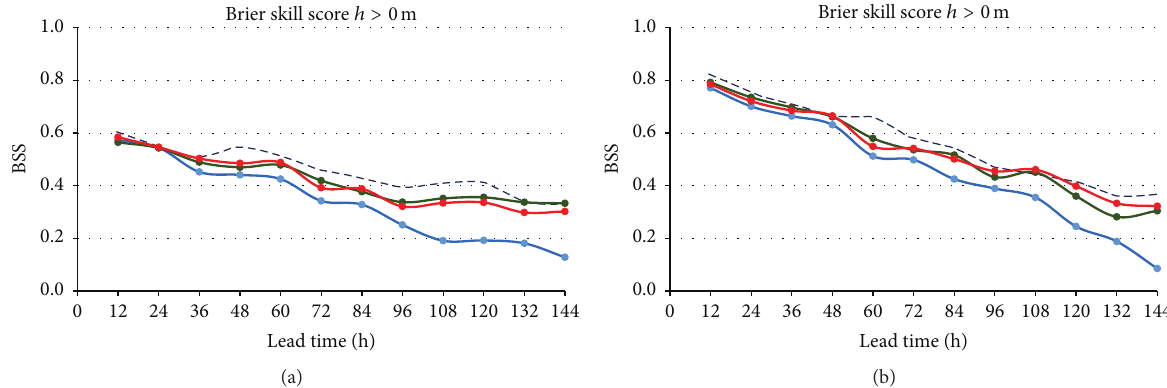
Figure 4: Brier skill score as function of lead time for the MULTIPDF dressing method applied to three different forecasts (green continuous cum dotted line: DF, red continuous cum dotted line: EMF, and blue continuous cum dotted line: CRF) is compared to the EPS BSS (blue dash line). In (a)/(b), the BSS index is computed with respect to observations/hindcast, considering SR =